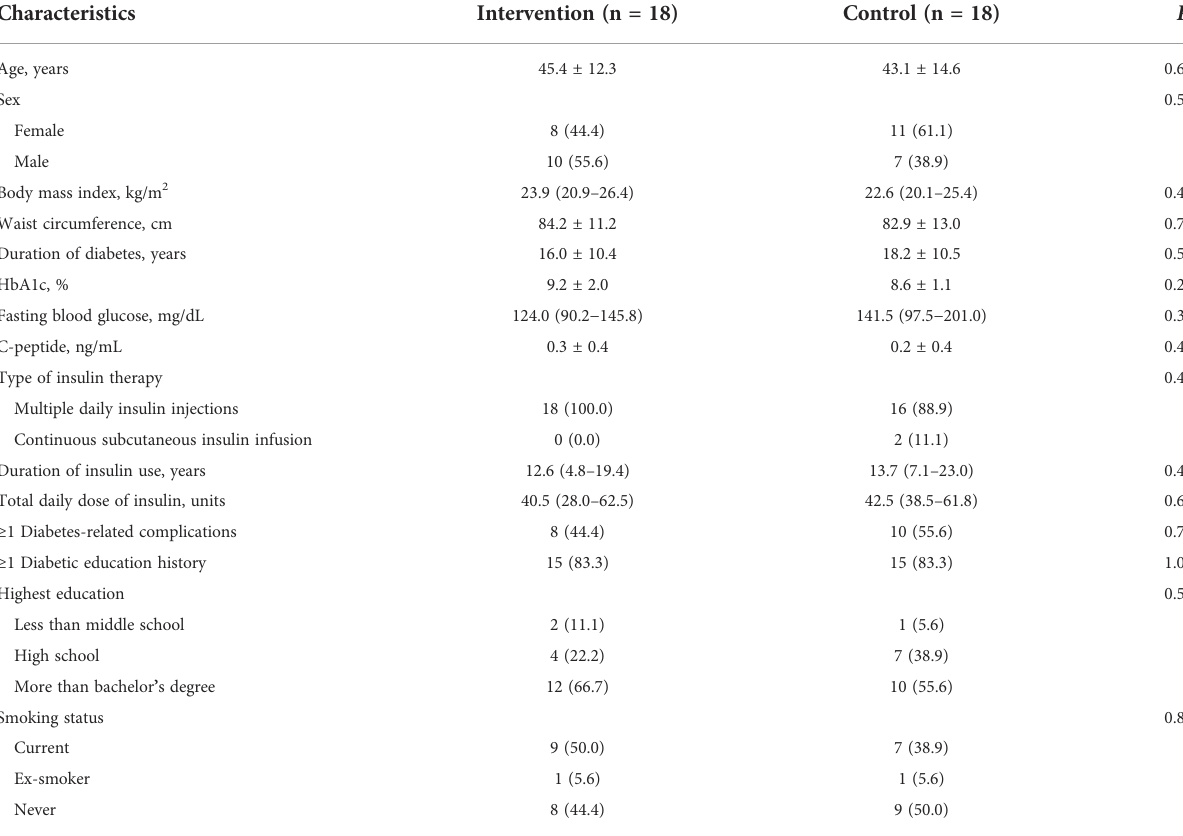
TABLE 1 Baseline characteristics of study